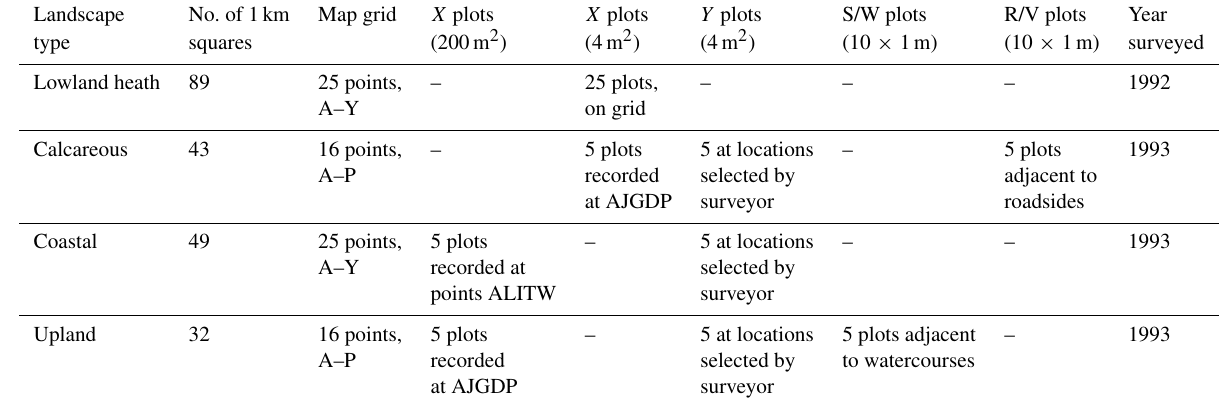
Table 5. Summary of vegetation plot locations. Landscape